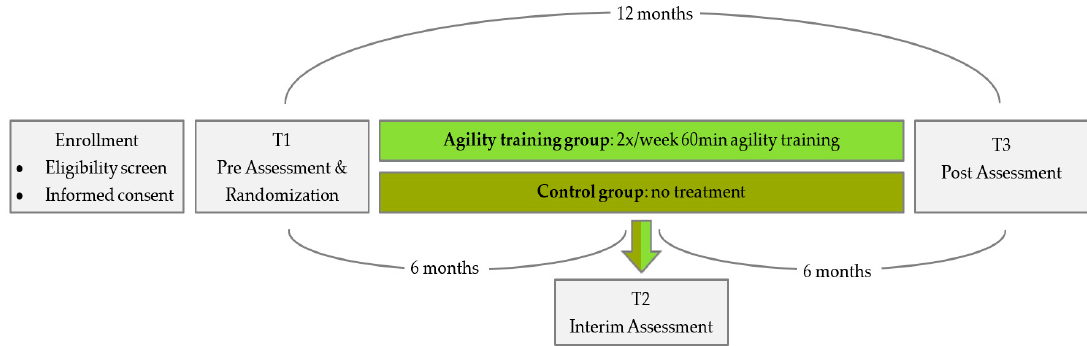
Figure 1. Study design.